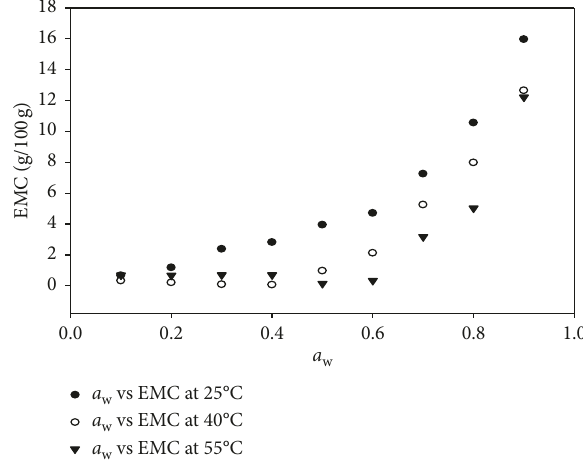
Figure 1: Adsorption EMC of pure MF at 25, 40, and 55 ° C.